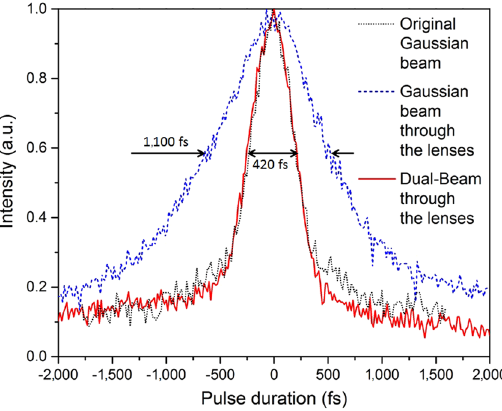
Figure 2. The ultrashort laser pulse duration remains unaffected after been focused using the Dual-Beam technique compared to conventional